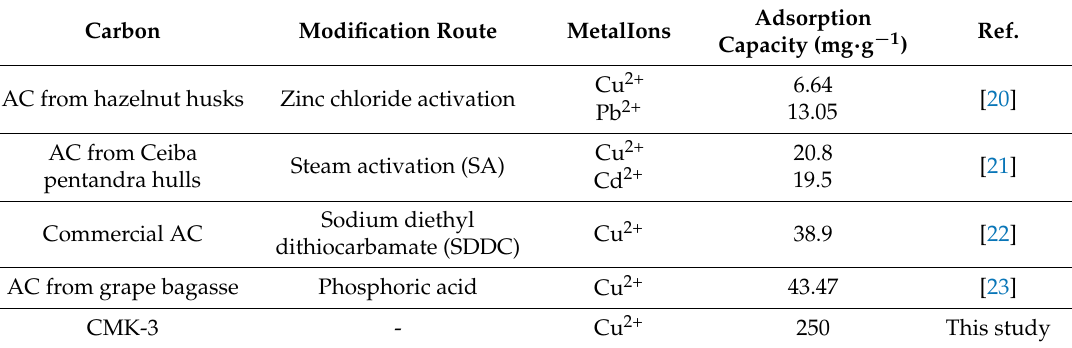
Figure 7. 2D and 3D surface response plots of the quadratic model for copper adsorption on CMK-3 (hold values: M = 10 mg, T = 35°C, C = 150 ppm). Table 6. Heavy metal adsorption on activated carbon (AC).